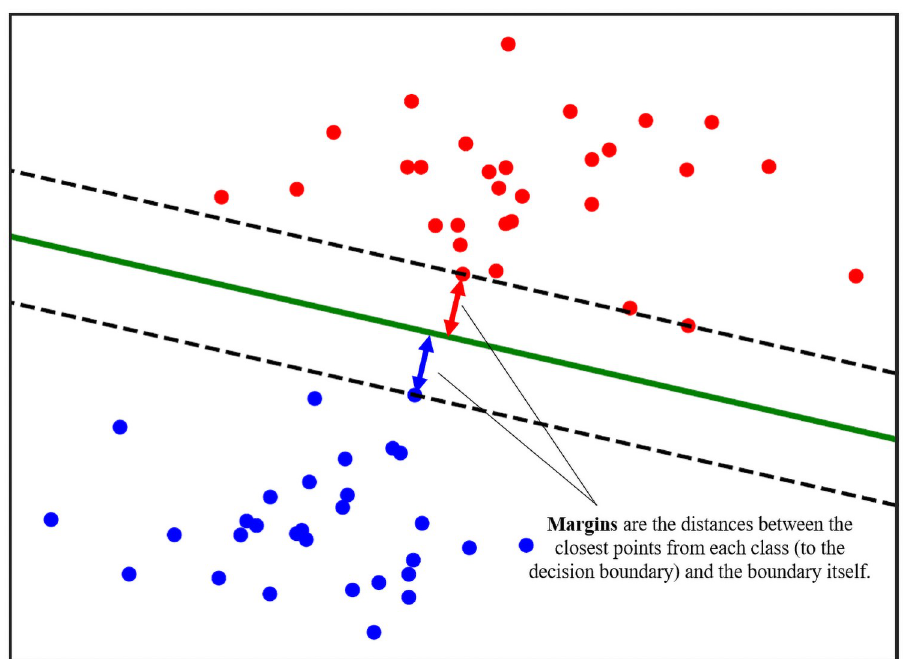
Fig 6. Visualization of a linear separating hyperplane and separating margins in a 2-class SVM model.